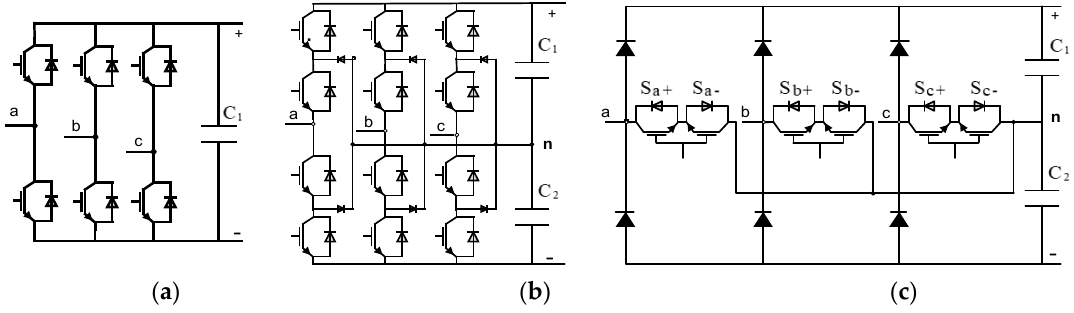
Figure 1. ( a ) Two-level converter; ( b ) Three-Level NPC converter; ( c ) Three-level Vienna rectifier.